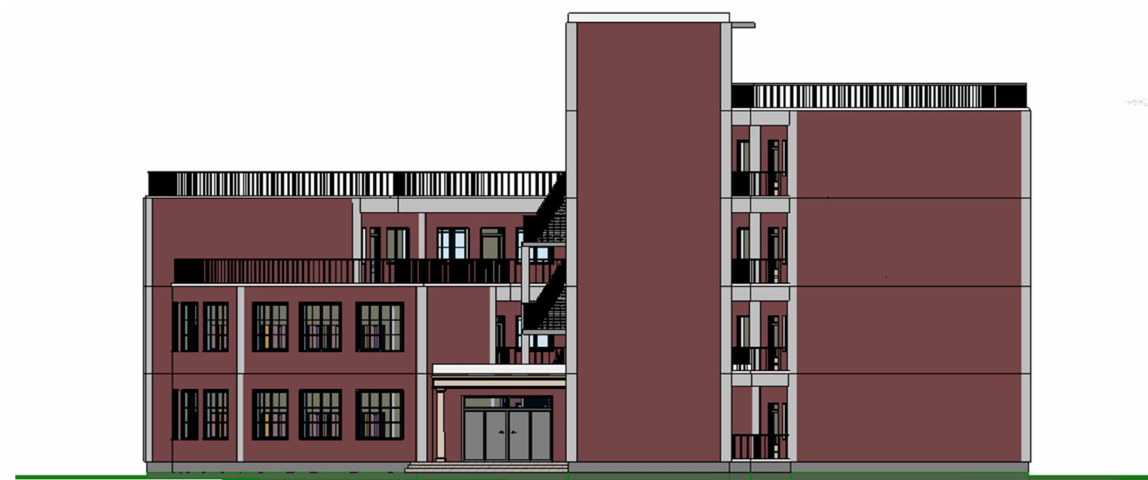
Figure 8. Modeling of this case study.